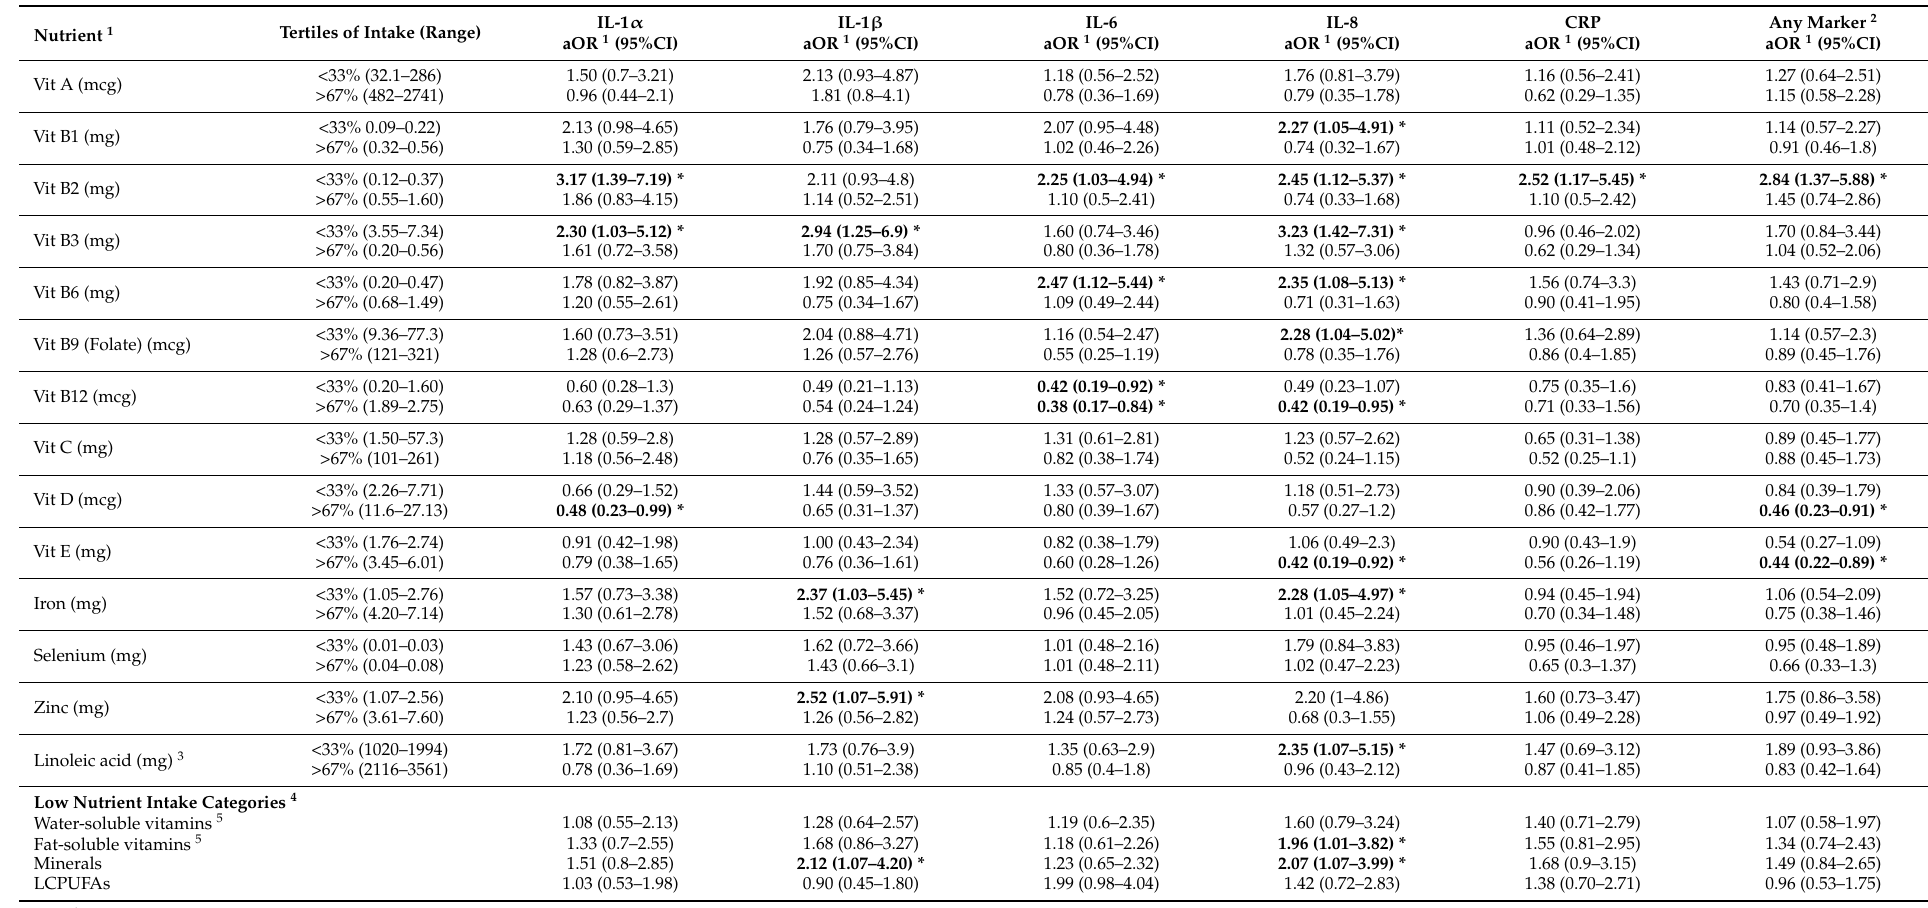
Table 3. The adjusted odds of cord blood inflammation ( ≥ 75th percentile) by tertile of maternal nutrient intake ( n = 251 mothers and their term infants). (Reference is the middle tertile of nutrient